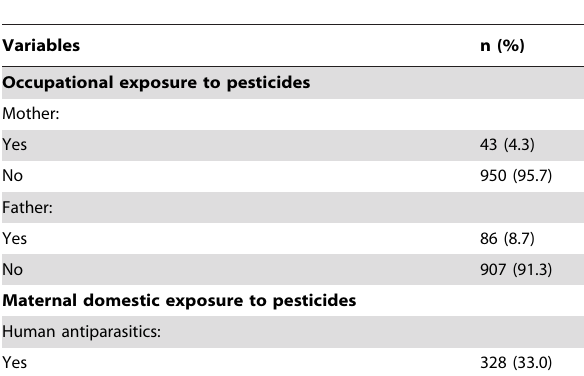
Table 3. Characteristics of prenatal exposure to pesticides (n=993).